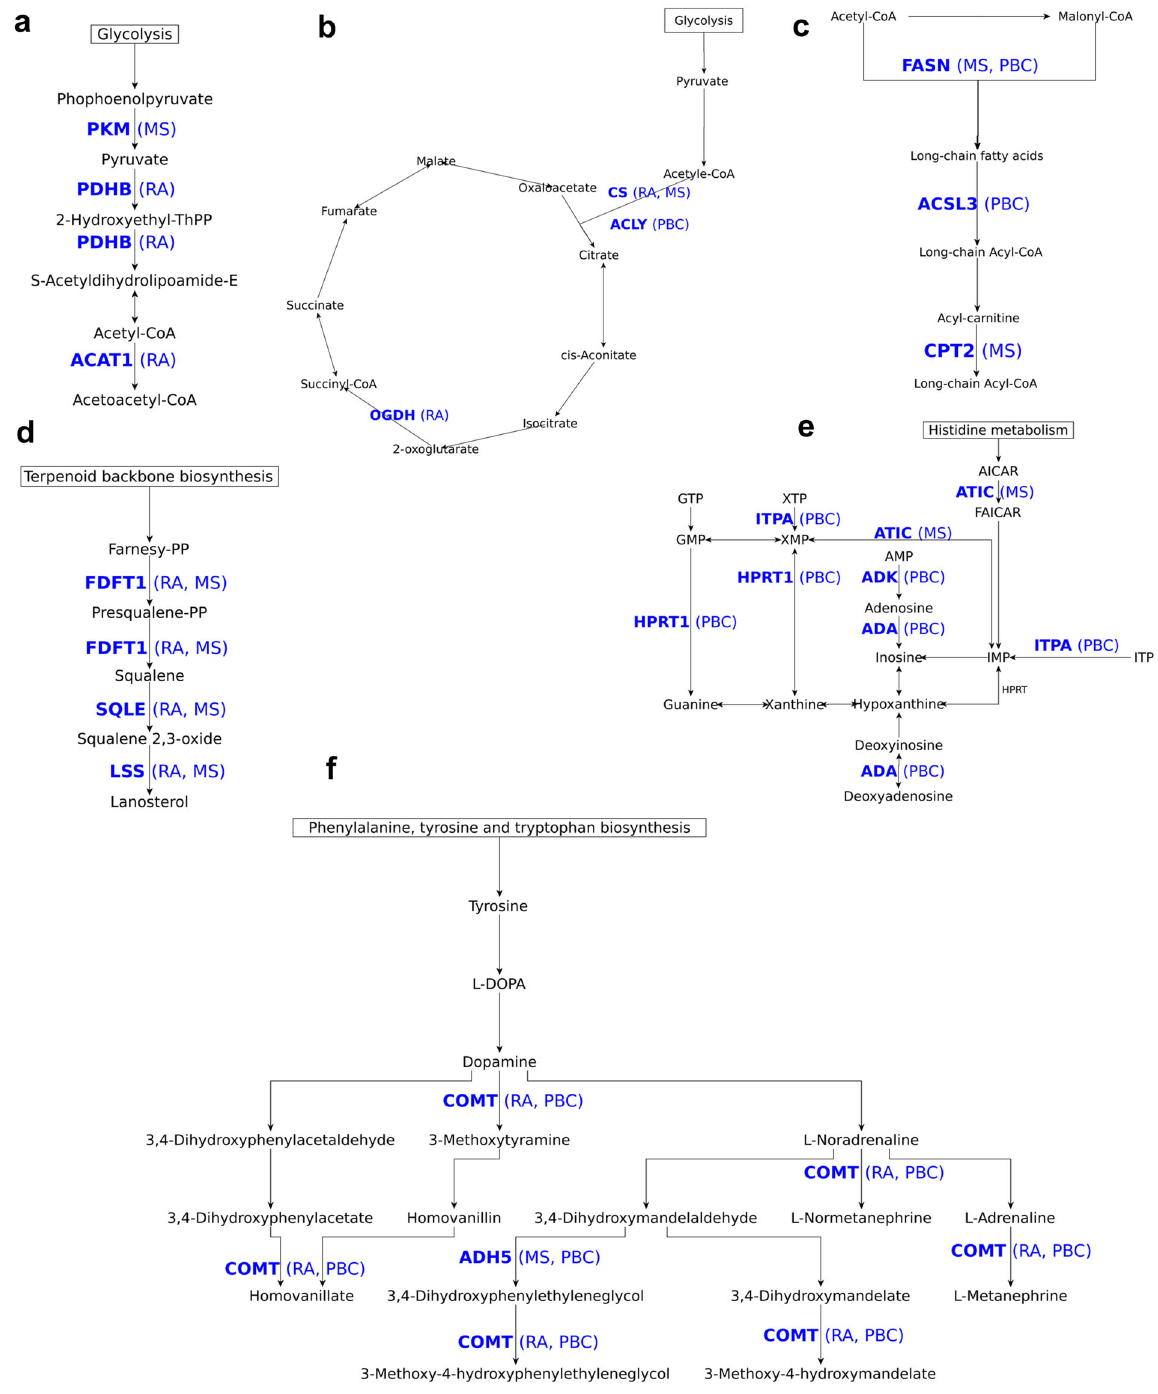
Fig. 6 Examples of identi fi ed drug targets mapped on the metabolic pathways. Relevant sub-networks of pathways where drug targets were mapped are shown for a pyruvate metabolism, b TCA cycle, c fatty acid biosynthesis, d steroid biosynthesis, e purine metabolism, and f tyrosine metabolism. The mapped drug targets (bold font) and diseases (in brackets) are shown in blue colored